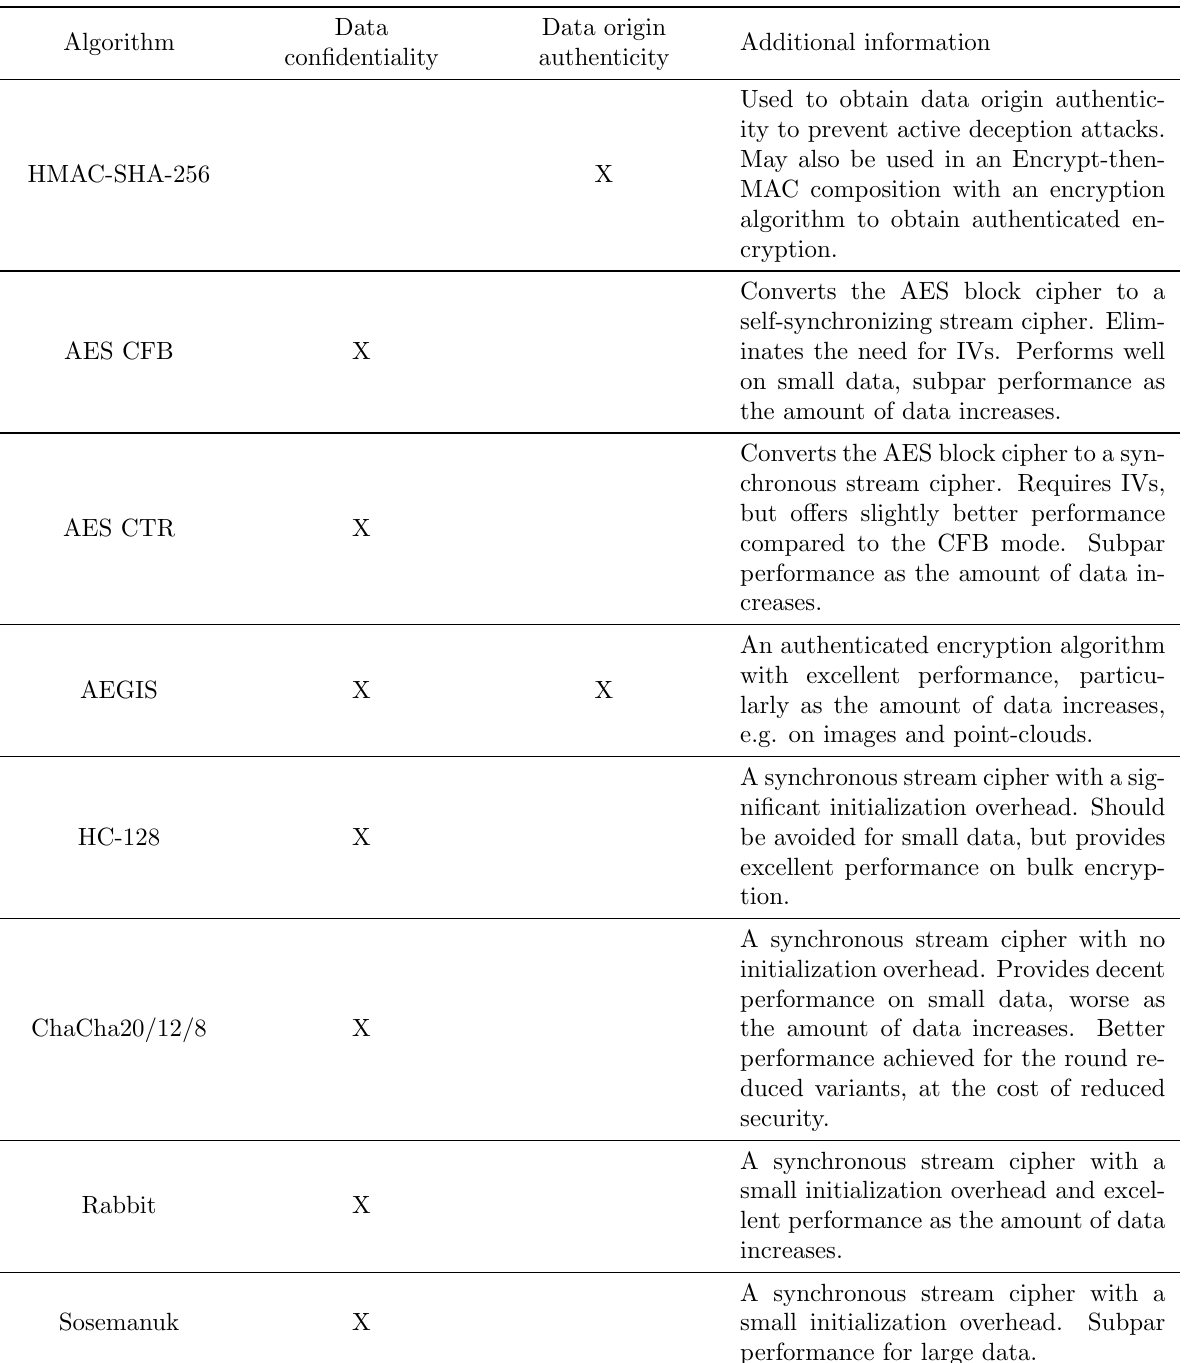
Table 2: An overview of the properties of the cryptographic algorithms in the